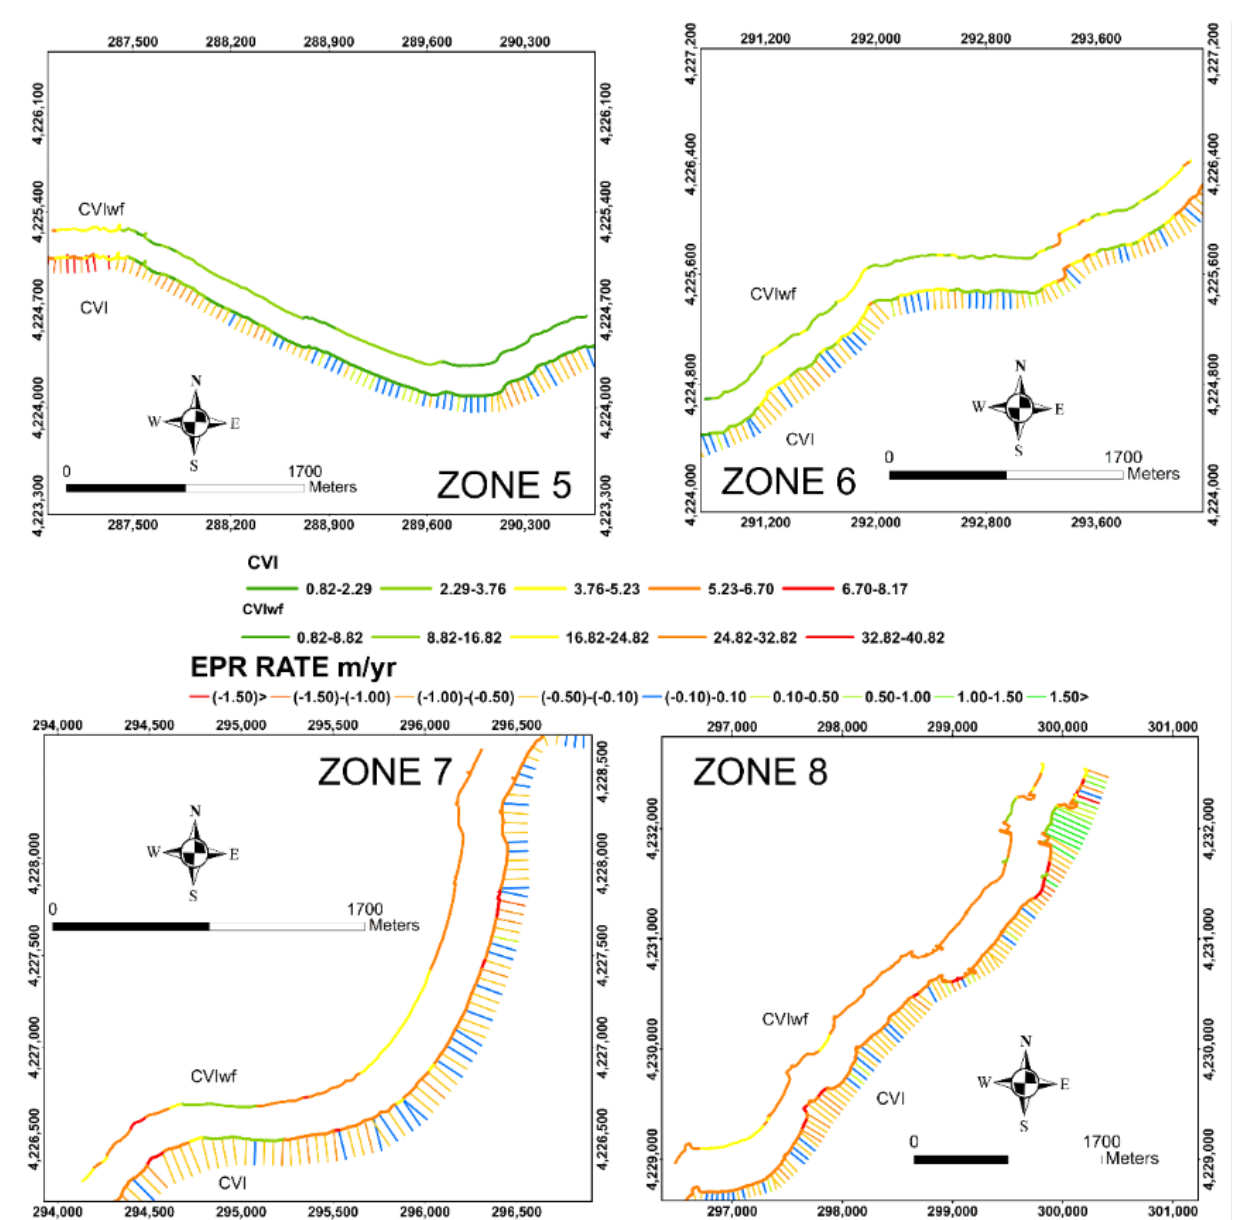
Figure 10. Comparison between the EPR and the vulnerability classes in Zones 5–8.